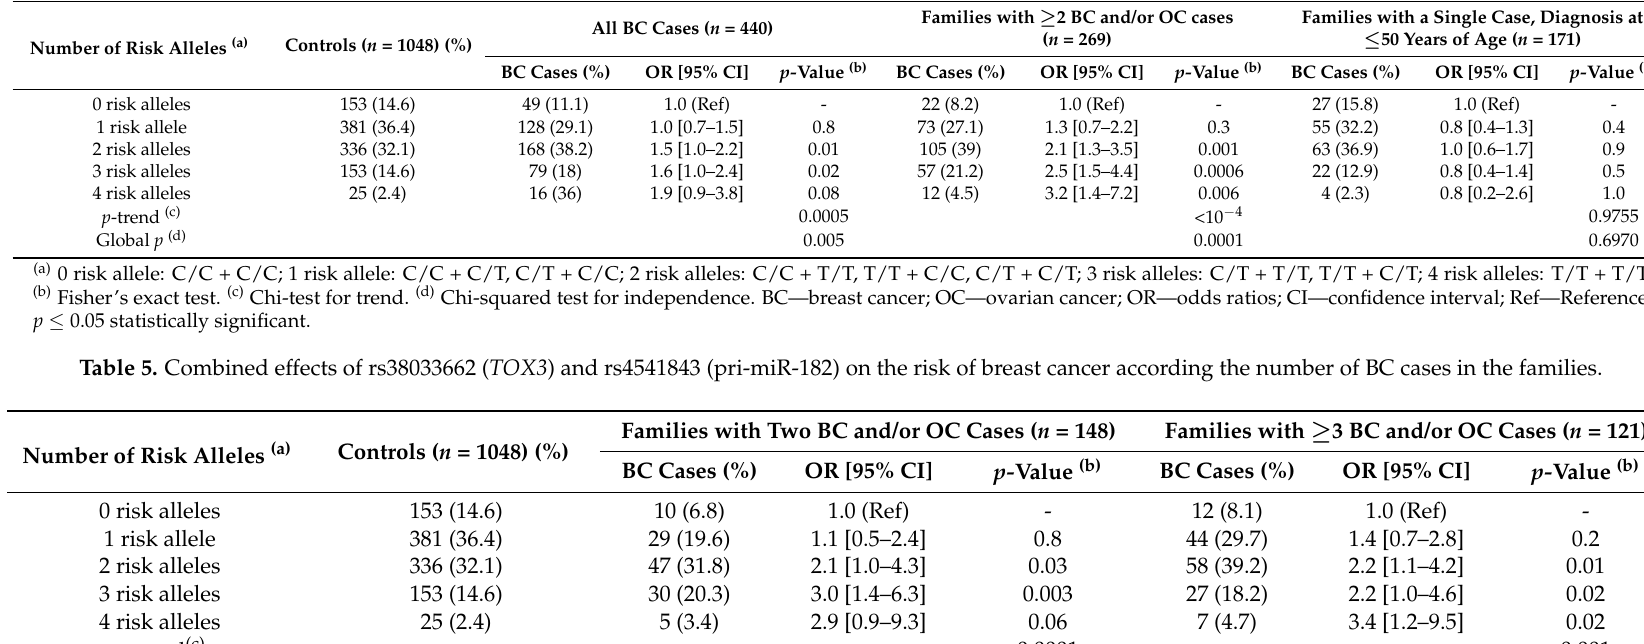
Table 4. Combined effects of rs3803662 ( TOX3 ) and rs4541843 (pri-miR-182) on the risk of breast cancer.